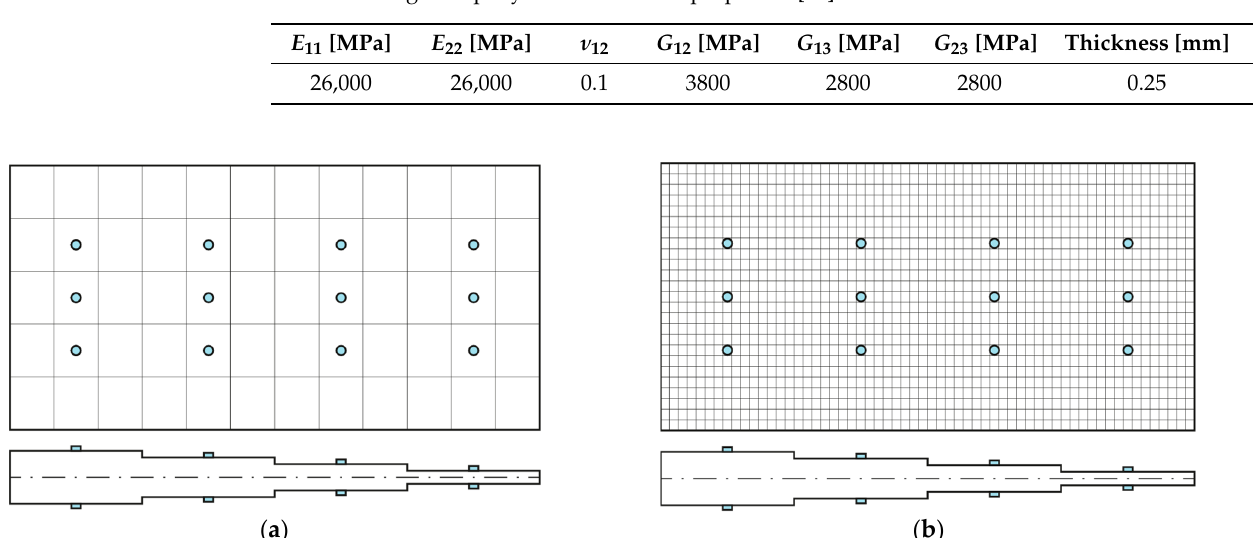
Figure 3 . ( a ) Composite plate dimensions and ( b ) layup sequence. Figure 3. ( a ) Composite plate dimensions and ( b ) layup sequence. Table 1. Fiberglass-epoxy lamina material properties [45] for the direct FEM. Table 1. Fiberglass-epoxy lamina material properties [45] for the direct FEM.